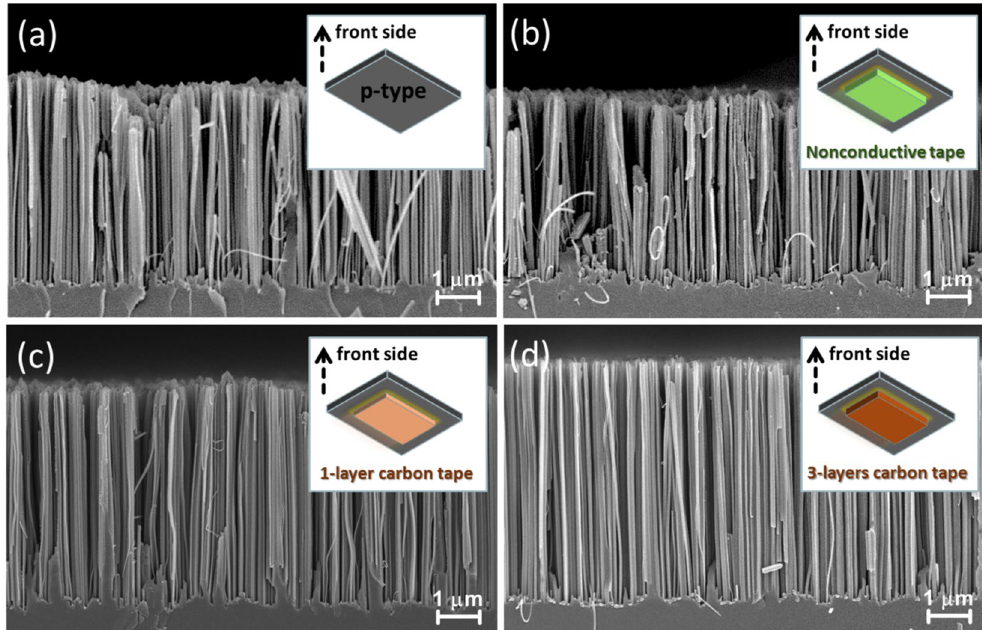
Figure 2. Cross-sectional SEM images of aligned Si nanowire arrays obtained from ( a ) conventional MaCE and back-substrate assisted MaCE with back substrates of ( b ) nonconductive tape, ( c ) one-layer and ( d ) three- layer conductive carbon tapes. The corresponding sample configurations are depicted in the insert figures, respectively.